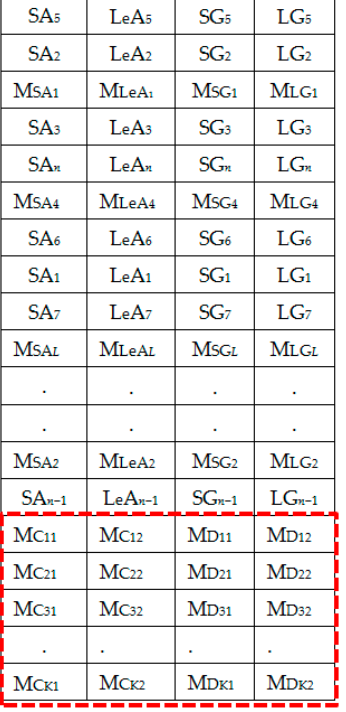
Figure 11. Set 3: OR + LA1 + SH + LA2 feature set with local averages.